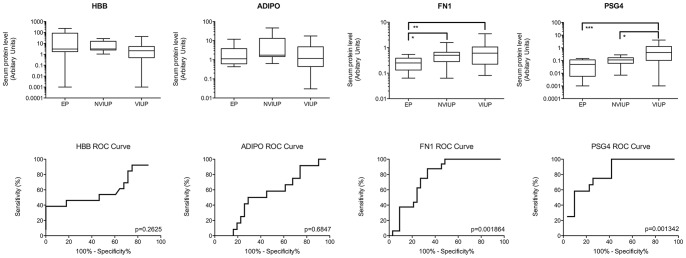
Western blots of individual whole sera from women undergoing surgical management of EP, surgical management of NVIUP and surgical termination of VIUP were probed with antibodies specific for: HBB; ADIPO; FN1; and PSG4.Integrated density values of specifically labelled bands were normalised against a positive control (pooled VIUP serum). ROC curves were generated for ectopic vs non-ectopic patient groups.